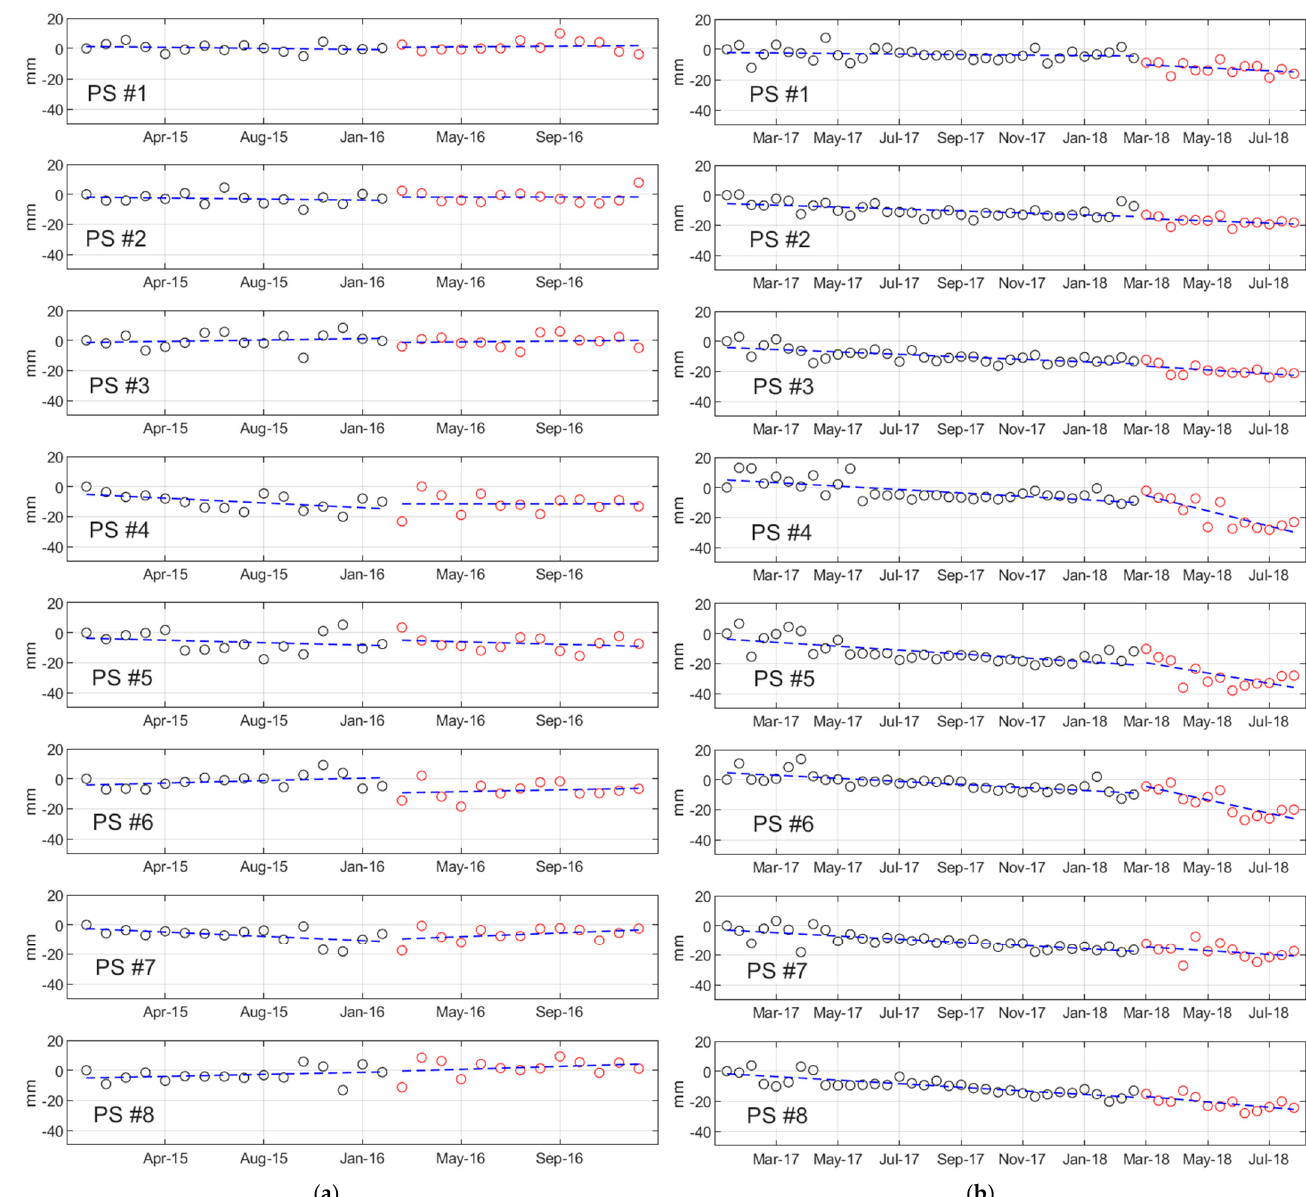
Figure 7. Time-series behavior of the eight PSs shown in Figure 6 for ( a ) the first and ( b ) second groups. The vertical axis shows the millimeter displacement rate.